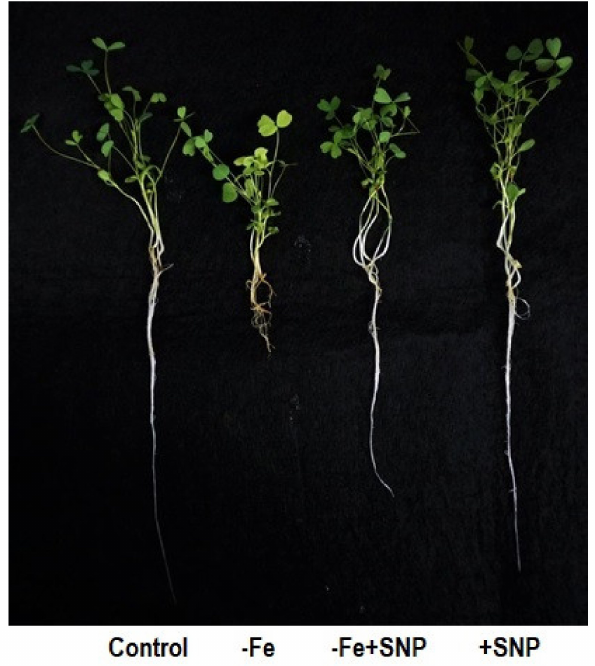
Figure 1. Morphological changes in alfalfa cultivated with different growth conditions: control (25 µ M FeNaEDTA); − Fe (0.1 µ M FeNaEDTA); − Fe (0.1 µ M FeNaEDTA) and sodium nitroprusside (SNP, 100 µ M) as nitric oxide (NO) donor; and SNP (100 µ M).